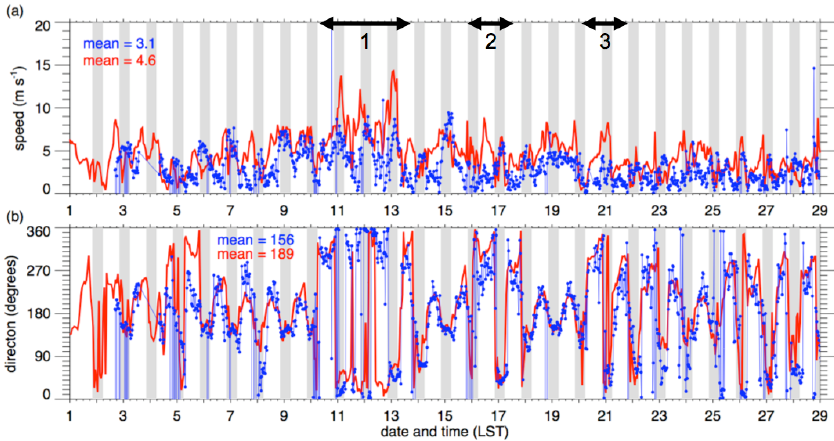
Figure 5. Observed (a) wind speed and (b) direction at the 100 m AGL range gate from the T1 sodar (blue 974 Fig. 5. Observed (a) wind speed and (b) direction at the 100ma.g.l. range gate from the T1 sodar (blue dots) along with the simulated winds dots) along with the simulated winds from the operational WRF forecasts at the same level (red lines). 975 Gray shading denotes nighttime periods and arrows denote three periods of northwesterly synoptic flow 976 from the operational WRF forecasts at the same level (red lines). Gray shading denotes nighttime periods and arrows denote three periods of associated with the passage of troughs over California. 977 northwesterly synoptic flow associated with the passage of troughs over California.